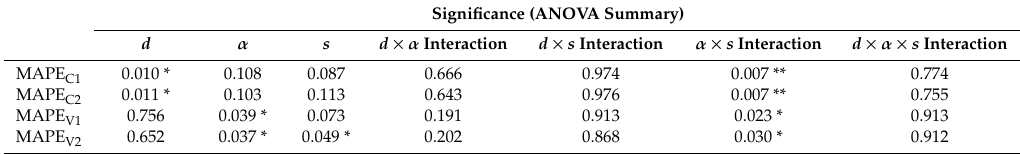
Table 5. ANOVA summary results of MAPE of stem circumference and